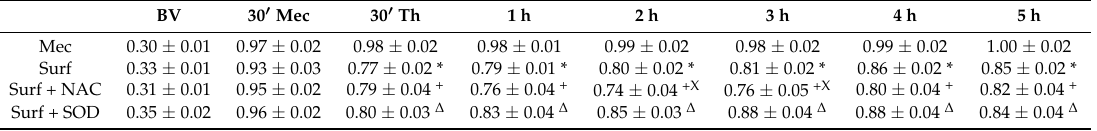
Table 1. Mean airway pressure (kPa) before meconium administration (BV) and 30 min (30 ′ ) after meconium (Mec) and therapy (Th) administration during 5 h of experiment.